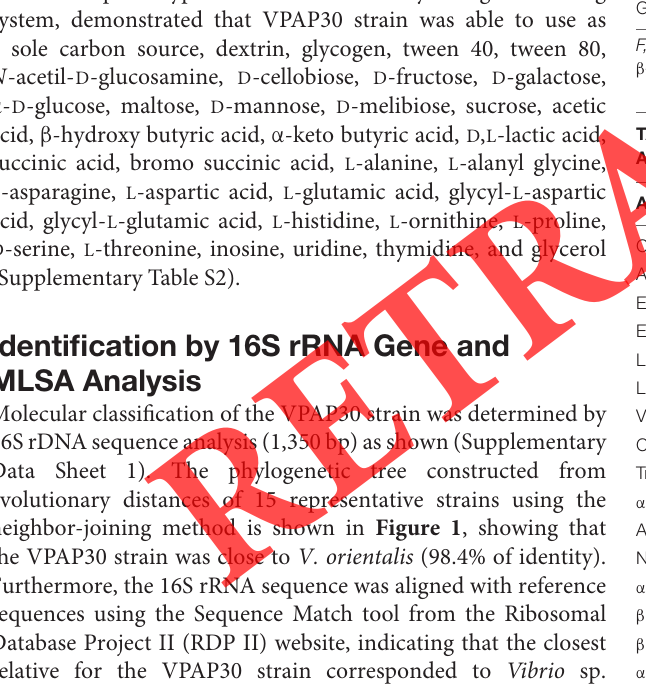
TABLE 2 | Enzymatic properties of V . tubiashii VPAP30 strain by using the API ZYM system